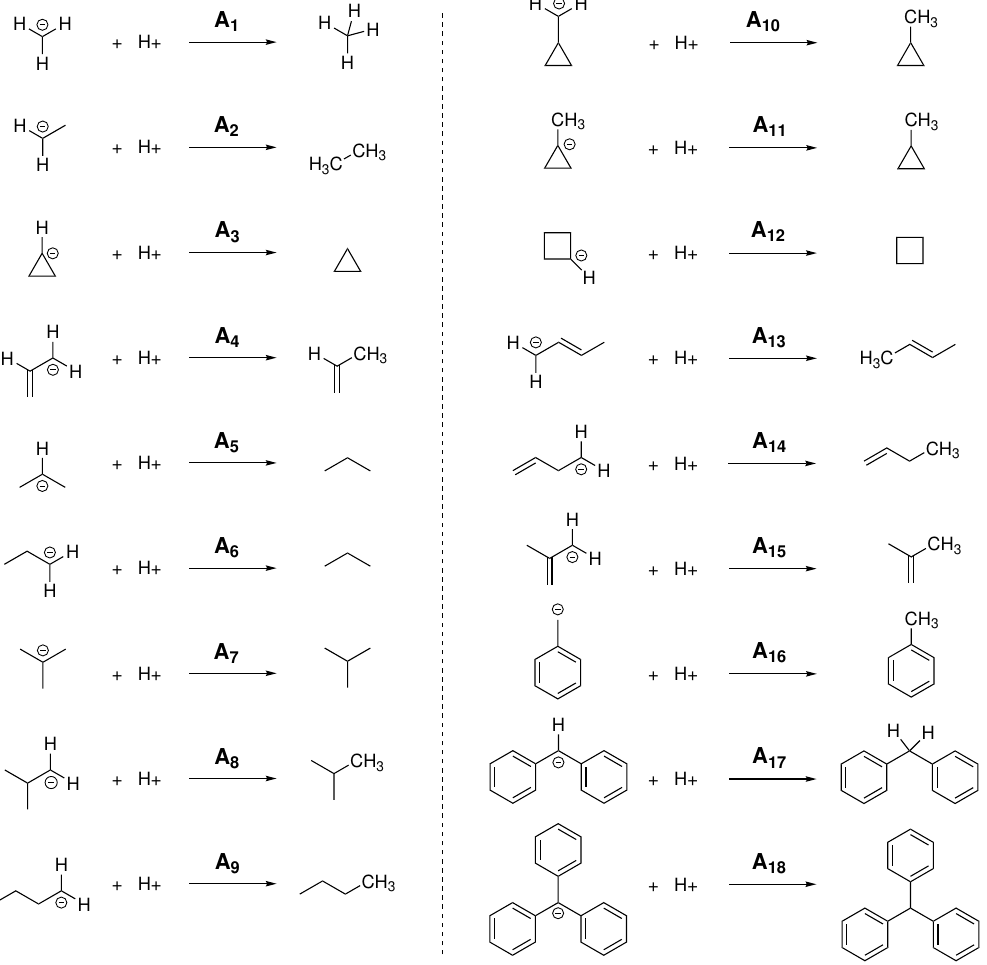
Figure 2. Schematic representation of the 18 different reactions used in this study for the calculation of proton affinity (PA) and gas-phase basicity